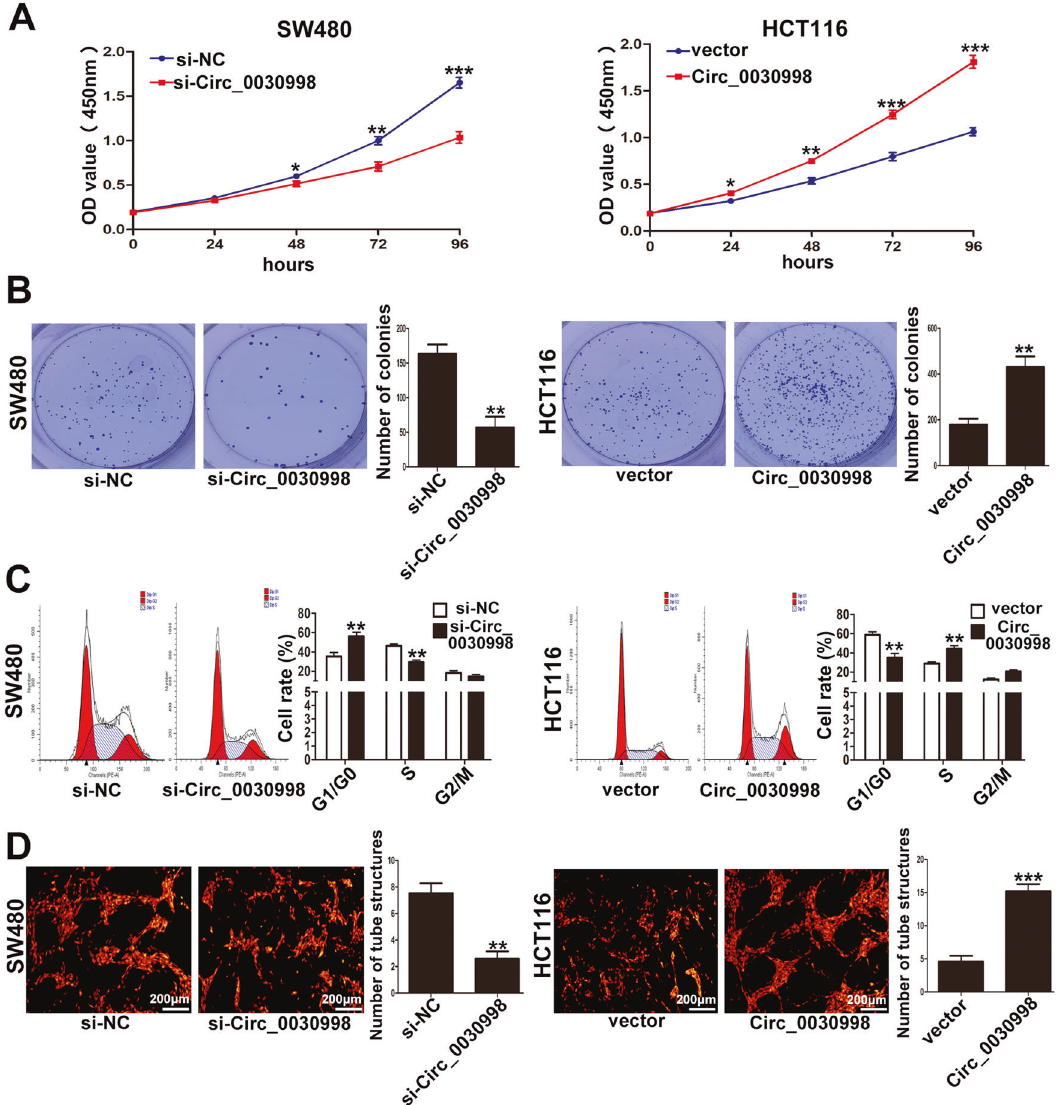
Fig. 3 Circ_0030998 promoted CRC cell proliferation and angiogenesis in vitro. A The proliferation ability of SW480 cells transfected with si-Circ_0030998 and HCT116 cells transfected with Circ_0030998 plasmid determined by CCK8 assays. B The cloning ability of transfected SW480 and HCT116 cells. C The effect of Circ_0030998 on cell cycle of SW480 and HCT116 cells. D The tube-like structures formation of HUVECs cultured in Matrigel-coated plates with conditioned medium from SW480 or HCT116 cells. * p < 0.05,** p < 0.01, *** p <